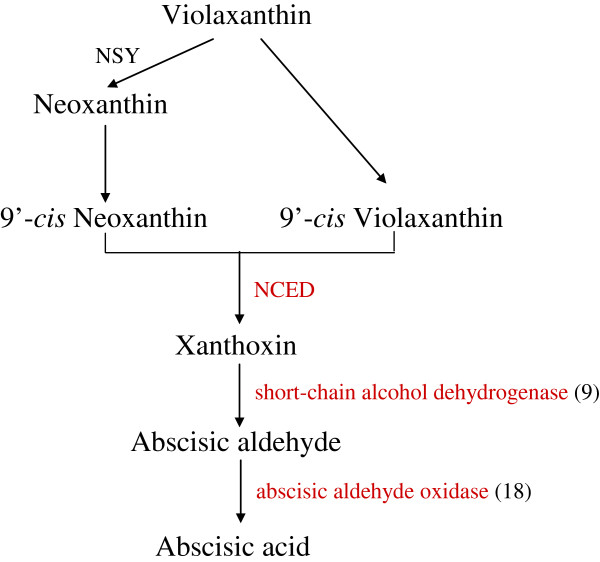
ABA biosynthetic pathway in chrysanthemum under dehydration. NSY: neoxanthin synthase; NCED: 9-cis-epoxycarotenoid dioxygenase. Genes in red mean up-regulated by dehydration. Numbers in brackets represent numbers of unique transcript regulated by dehydration stress.